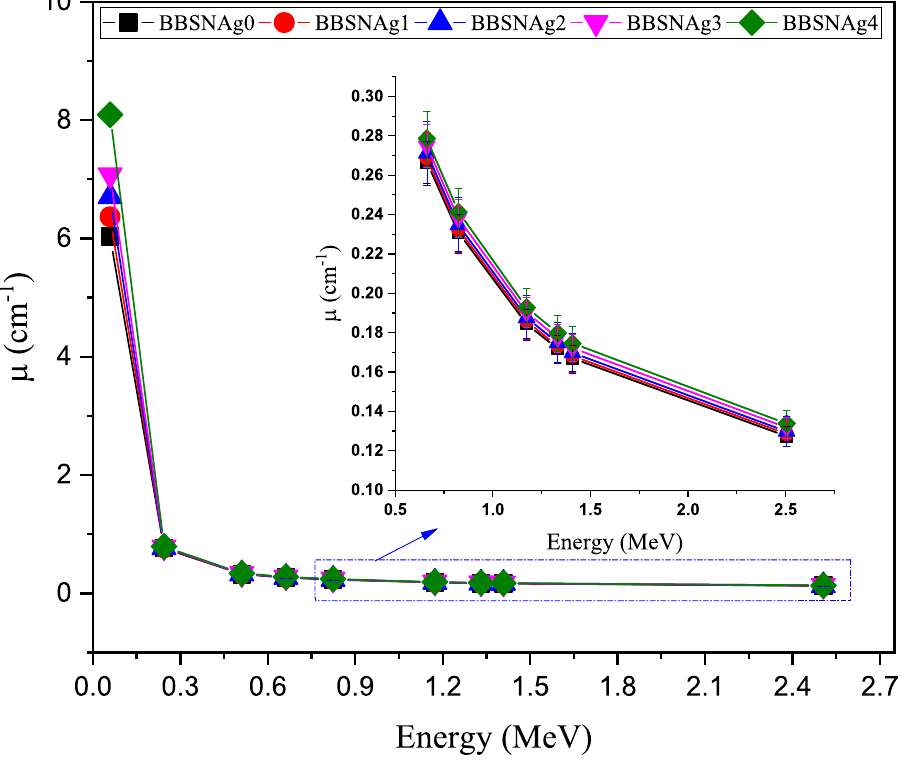
Figure 11. Variation of the linear attenuation coefficient versus the gamma-ray energy in the interval between 0.059 and 2.506